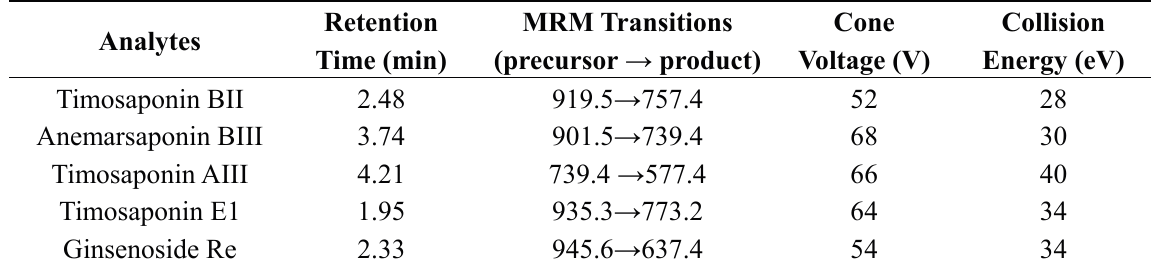
Table 6. Precursor/product ion and parameters or MRM of compounds used in this